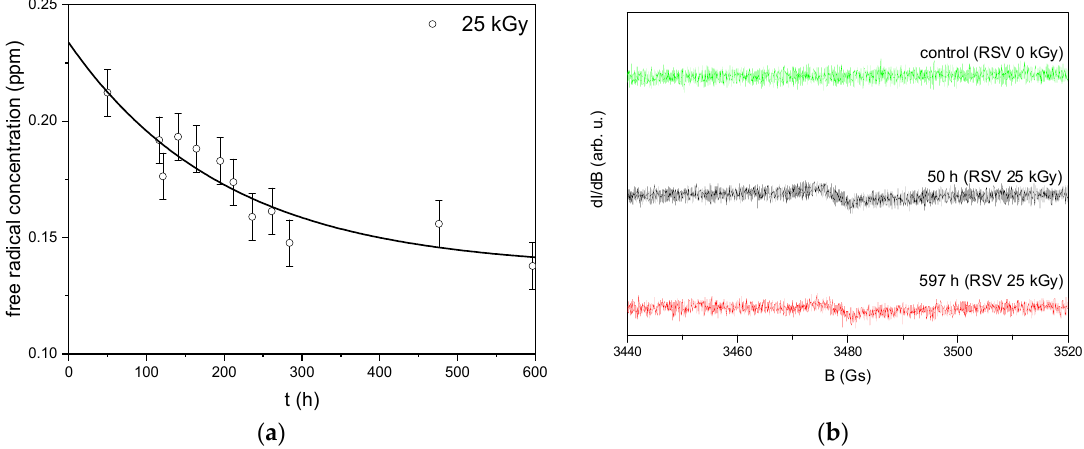
Figure 1. ( a ) Concentration of free radical vs. time after irradiation (25 kGy). The solid line is the approximation of Equation (4) to the experimental points; ( b ) EPR spectra of non-irradiated (green) and irradiated resveratrol recorded 50 h (black) and 597 h (red) after 25 kGy dose irradiation.